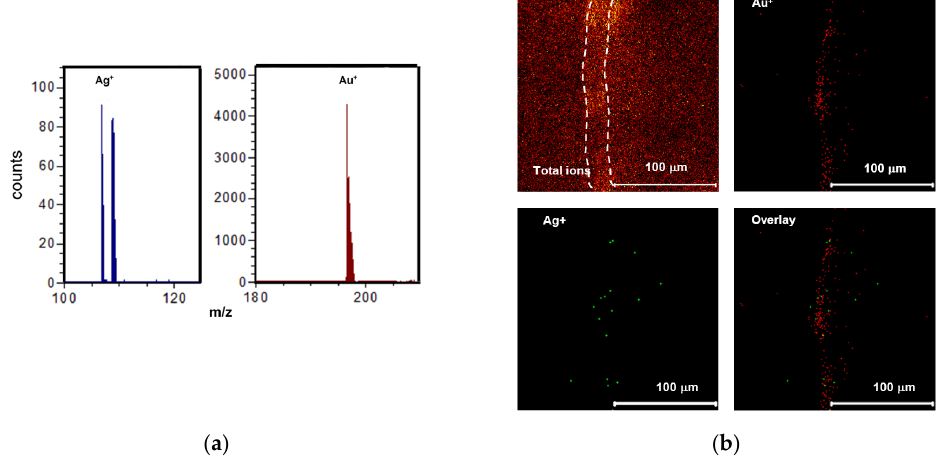
Figure 4. ( a ) Time of flight secondary ion mass spectrometry (ToF-SIMS) mass spectra of the m/z regions of silver and gold for sample A. ( b ) Maps showing total ions, Au + (red), Ag + (green) distributions. The dashed white lines mark the zone of the gold leaf. On the left of this zone there is the embedding resin and on the right the preparation layer. The overlay of the Ag and Au ion distributions is shown in the last image. The total count rates are 80 for Au and 10 for Ag.